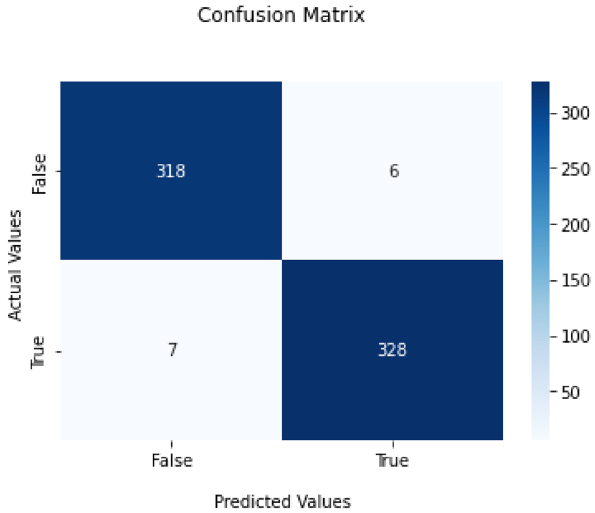
Figure 13. Confusion matrix on testing with twenty percent of original